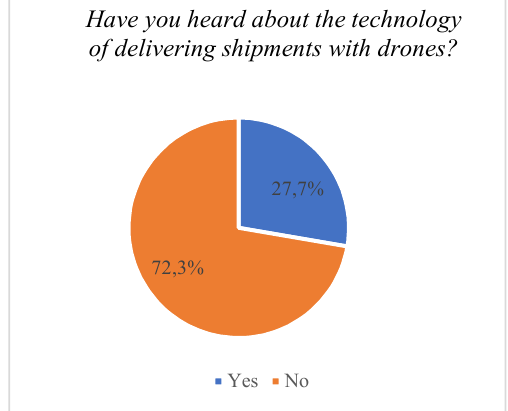
Figure 9. Question Results: Have you heard about the technology of delivering shipments with drones?